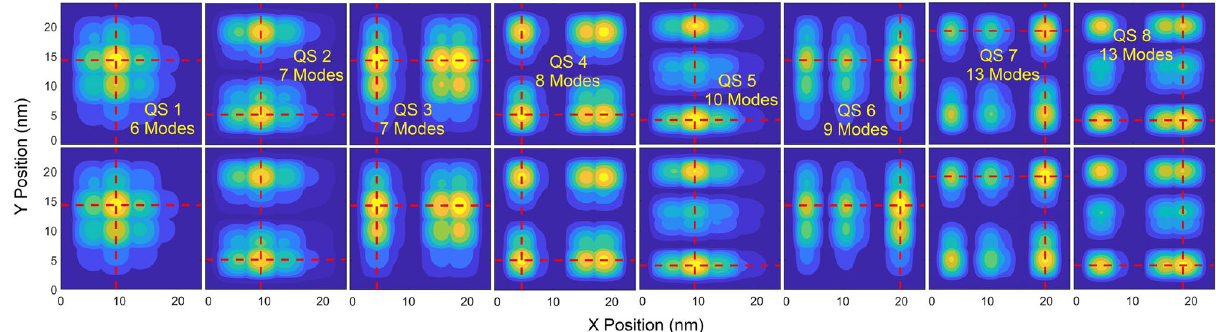
Figure 3. Contour of | ψ | 2 predicted by POD-Galerkin and DNS in upper and lower rows, respectively, in QSs 1–8. The horizontal and vertical red dashed lines reference the cross-sectional profiles of | ψ | 2 visualized in Fig.